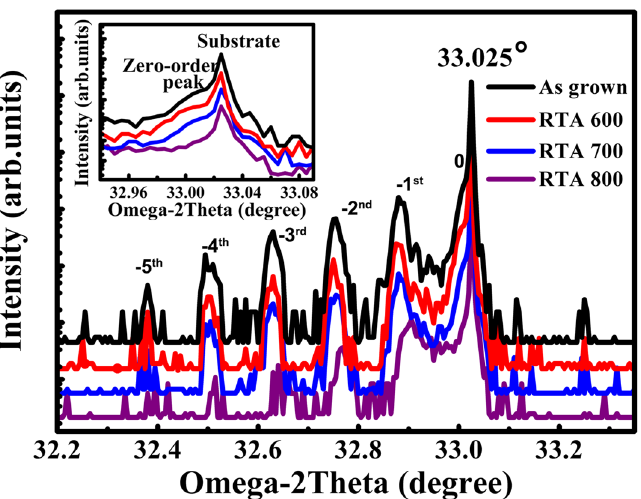
Figure 3. Triple-crystal X-ray diffraction patterns of all MQWs samples. The insert is partial enlarged XRD spectra from 32.95° to 33.08°.